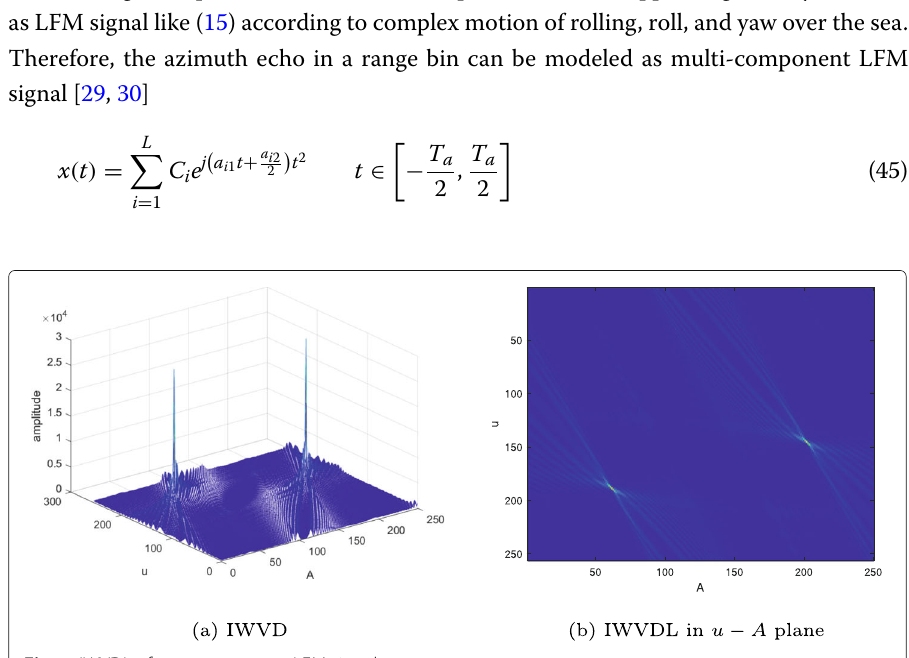
Fig. 7 IWVDL of two-component LFM